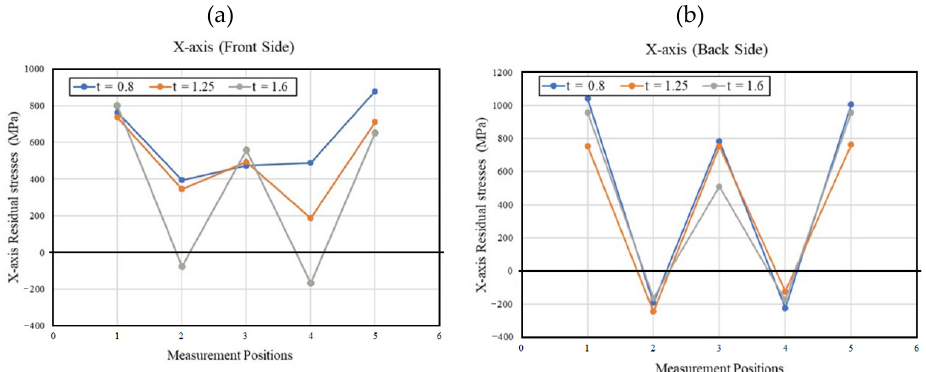
Figure 7. Residual stresses with corresponding measurement locations for the X-axis of the ( a ) front side, ( b ) back side.